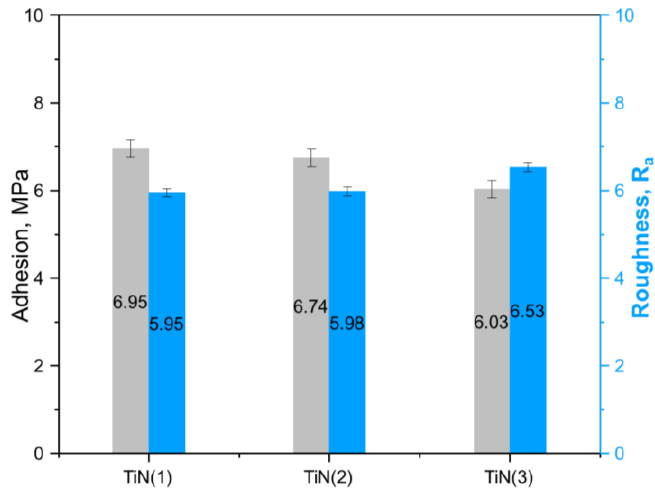
Figure 8. Adhesion strength and roughness of TiN coating.